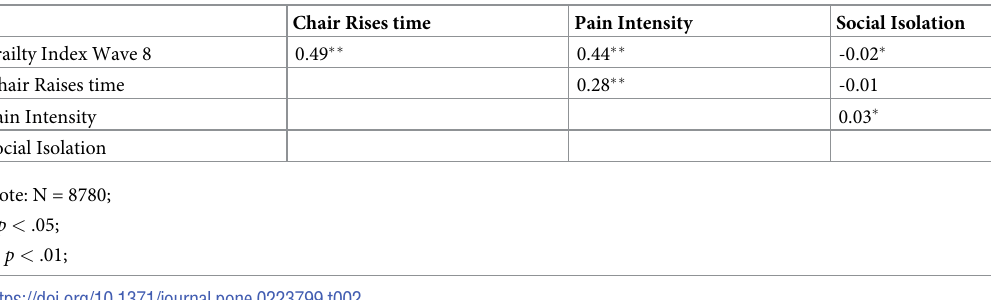
Table 2. Partial relationships (corrected for participants’